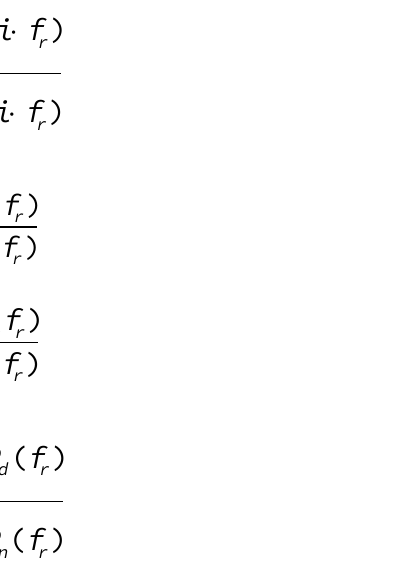
Select the RRSPs for fault diagnosis by SDI